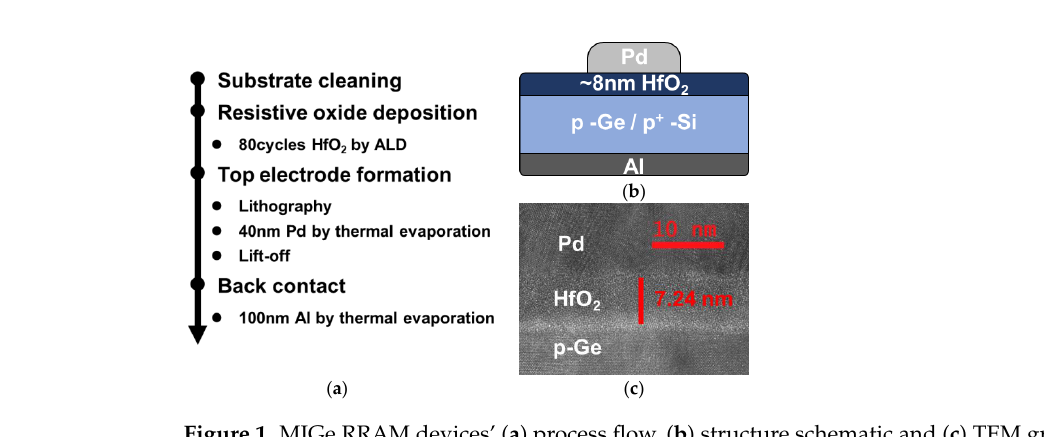
Figure 1. MIGe RRAM devices’ ( a ) process flow, ( b ) structure schematic and ( c ) TEM graph.